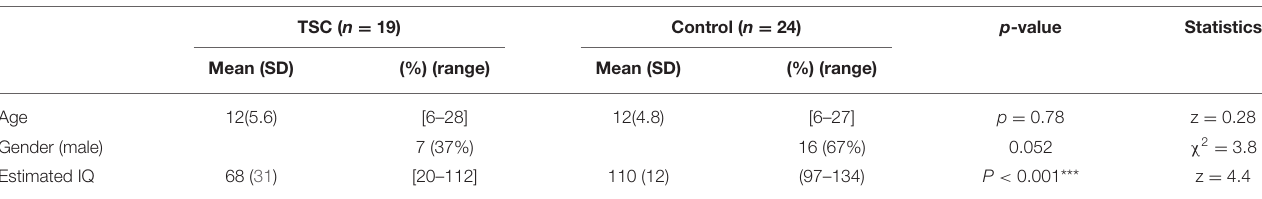
TABLE 1 | Descriptive data of the TSC and control